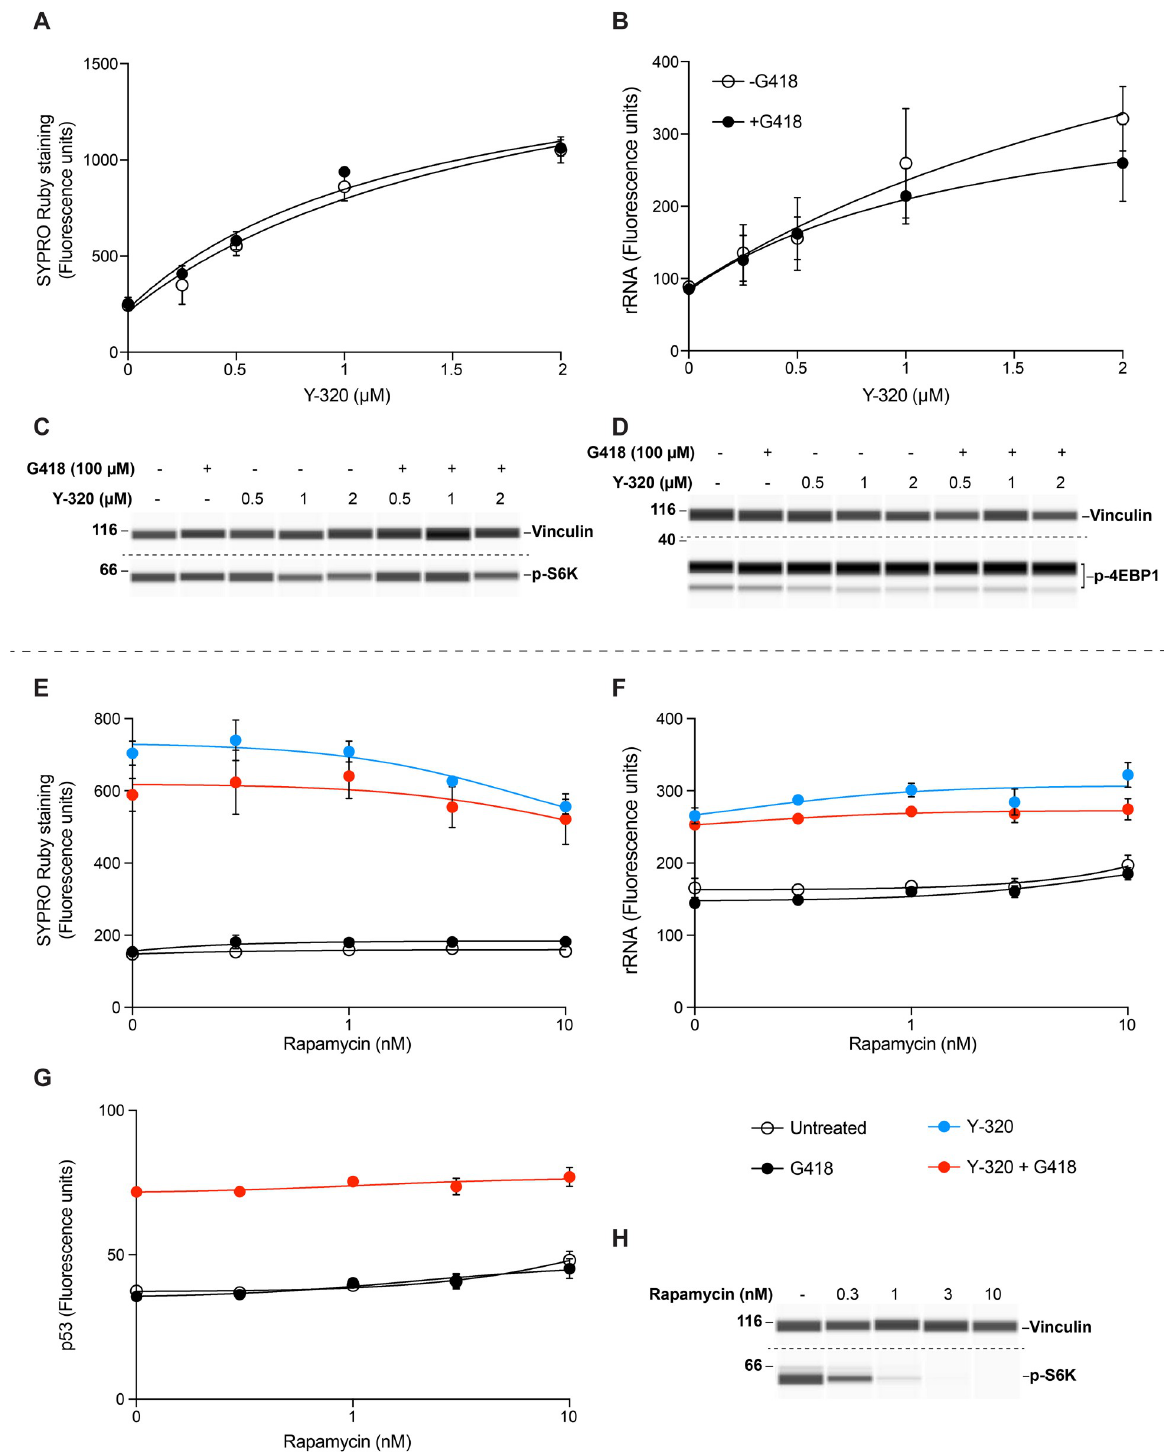
Fig 5. Y-320 stimulates protein synthesis independently of mTOR signaling. (A–D) Effect of Y-320 on Tsc2 −/− cells. Cells were exposed to 100 μ M G418 alone or in combination with the indicated concentrations of Y-320 for 48 h. They were then stained with SYPRO Ruby (A) or fluorescently labeled using rRNA antibody (B) ( n = 4 for A and B). Cells were lysed and equal amounts of protein were subjected to automated capillary electrophoresis western analysis. Shown are pseudo blots of chemiluminescence of bound p-S6K (C) and p-4EBP1 (D) antibodies. Vinculin was used as the loading control. (E–H) Effect of rapamycin in HDQ-P1 cells. HDQ-P1 cells were exposed to different concentrations